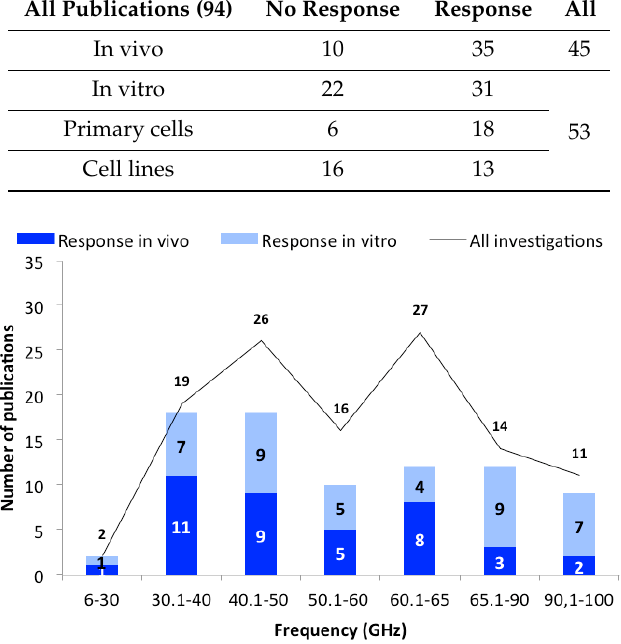
Figure 1. The number of publications as a function of frequency domains. The black line represents the total number of publications, and bars represent the in vivo (dark blue) and in vitro (light blue) studies with biological responses.